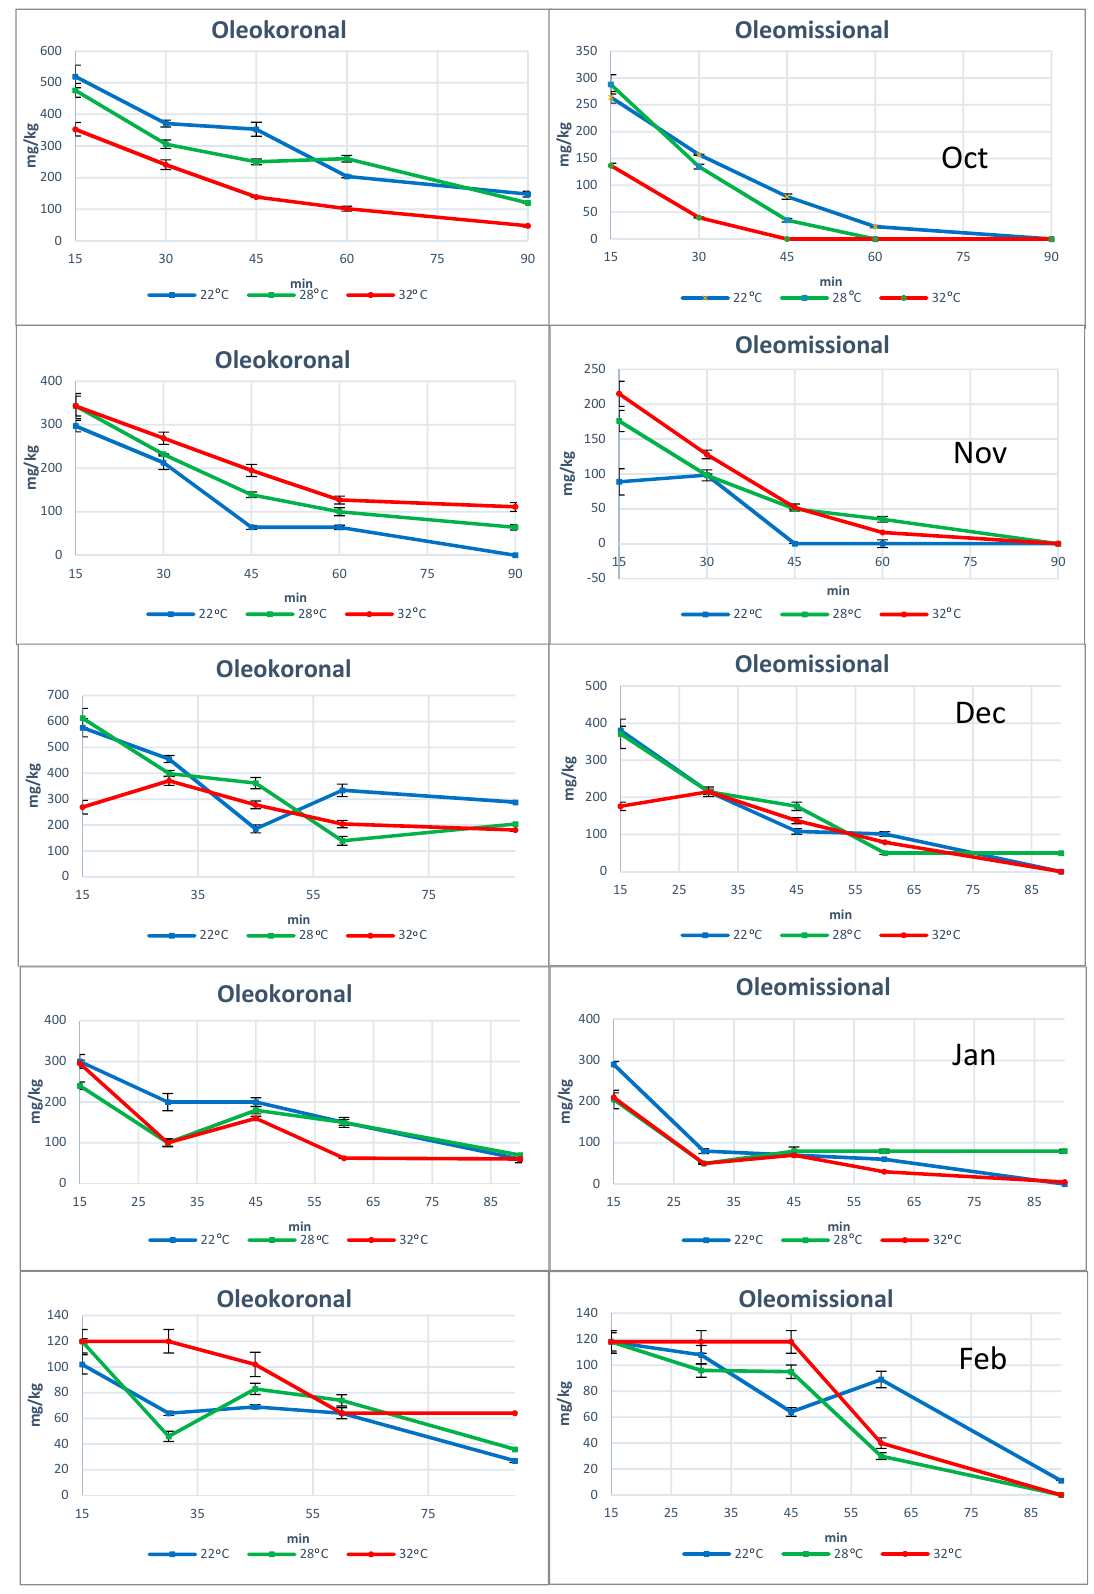
Figure 4. The concentration of Oleokoronal and Oleomissional at five different ripening degrees during malaxation at three different temperatures.